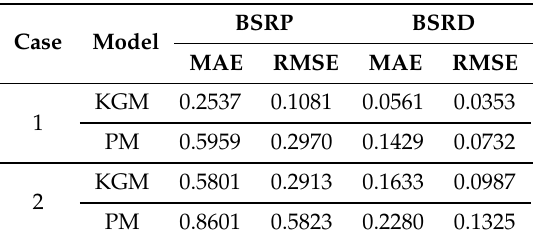
Table 2. Summary of quantified prediction